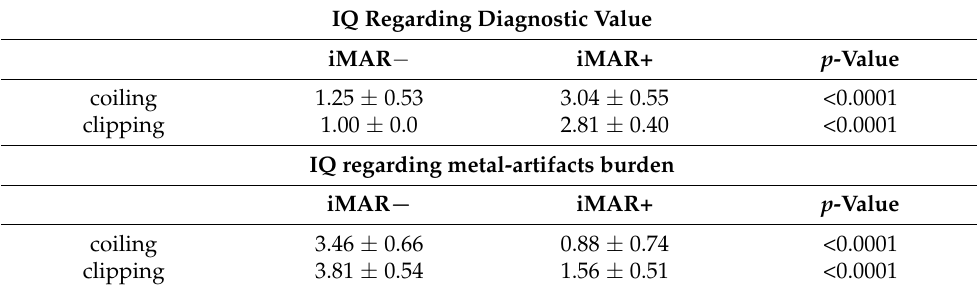
Table 4. Evaluation of image quality.